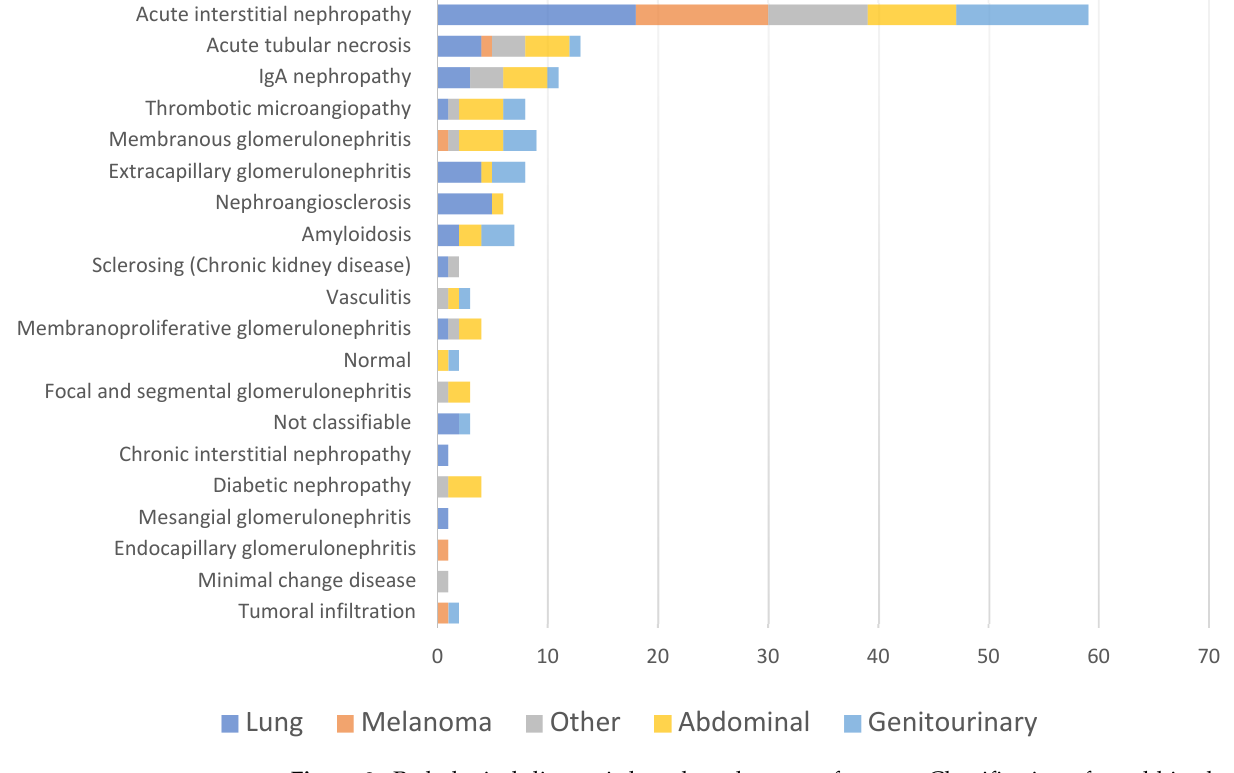
Figure 2. Pathological diagnosis based on the type of cancer. Classification of renal histological diagnoses in relation to the solid organ neoplasm of the